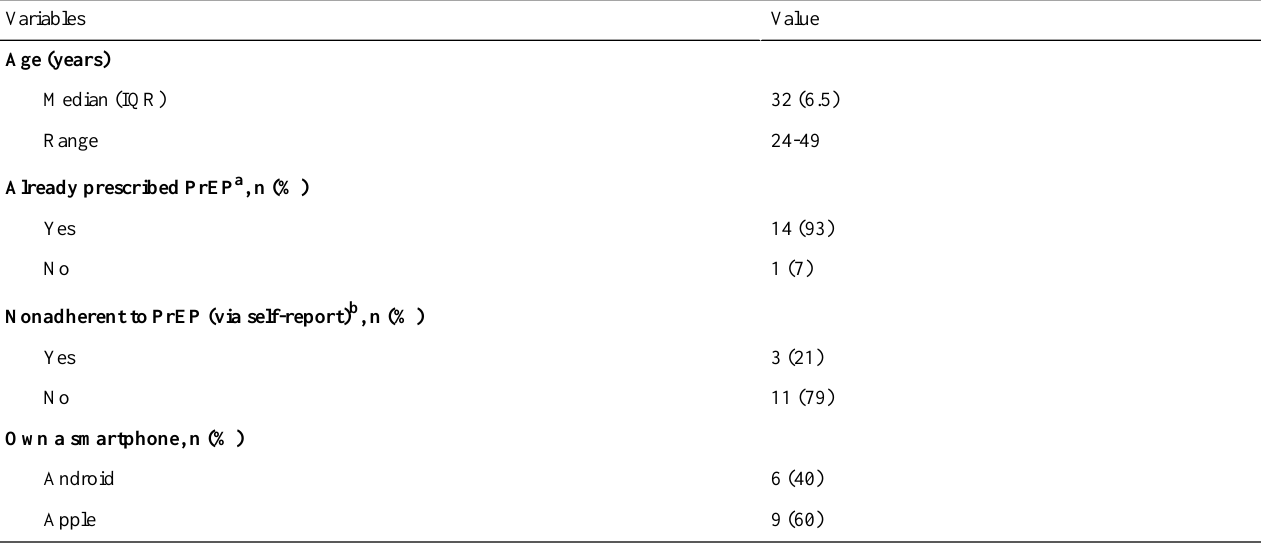
Table 1. Demographics of study population